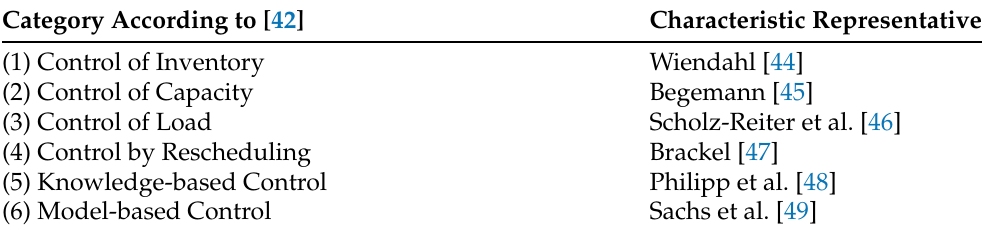
Table 1. Classification of control loops in manufacturing (adapted from